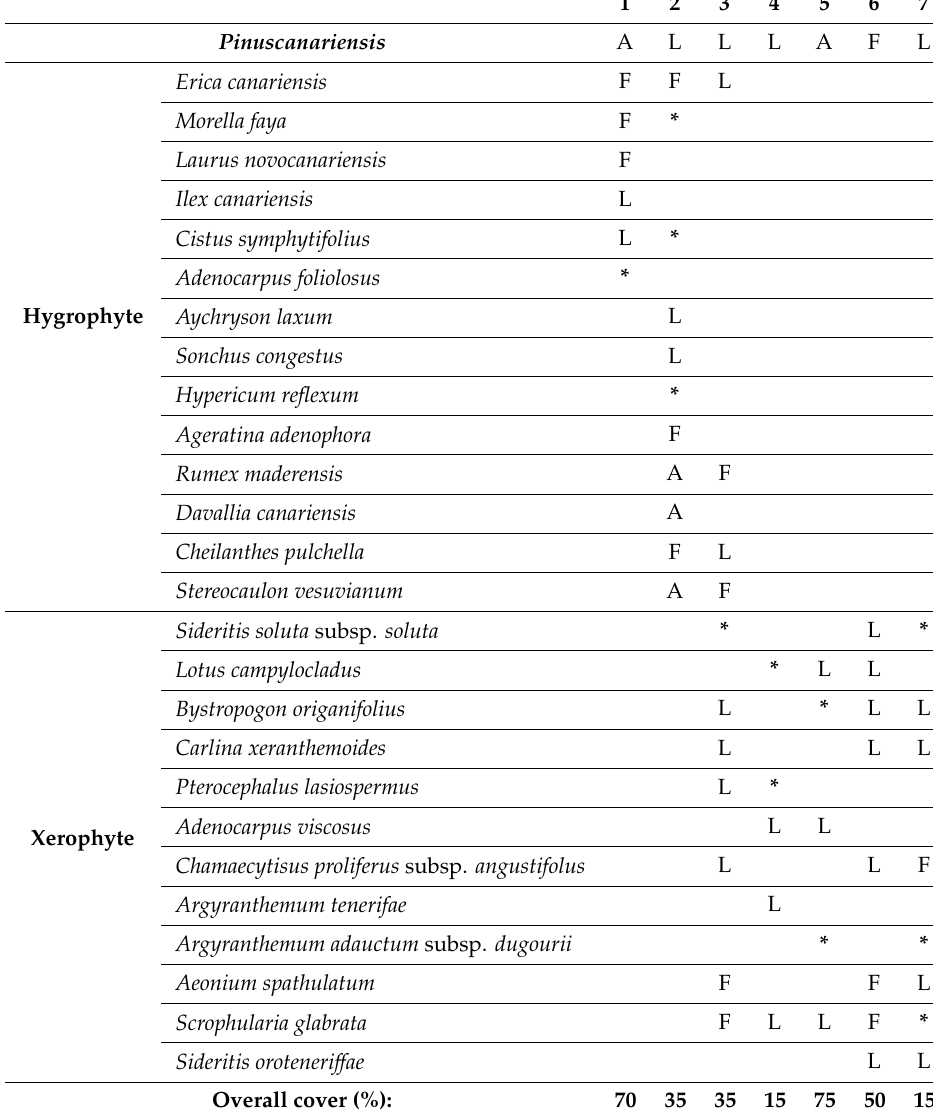
Table 1. The pine forests of the Chinyero Nature Reserve. Relationship between volcanic surfaces and the relative importance of the species. 1 Pine forest with monteverde on Holocene volcanoes with the regular e ff ect of the sea of clouds from the trade winds. 2 Open pine forest with scrub containing hygrophytic species and thallophytes on historical lava flows. 3 Open pine forest with scrub containing hygrophytic and xerophytic mountain species and thallophytes on historical and subhistorical lava flows. 4 Open pine forest with mountain scrub on historical pyroclasts. 5 Dense pine forest with open understorey of mountain species on Holocene pyroclastic cones and fields. 6 Semi-open pine forest with mountain scrub on Holocene lava flows. 7 Scrub ( Chamaecytisus proliferus subsp. angustifolus ) on Holocene lava flows. * Absent or very rare species, L Localised species, F Frequent species, A